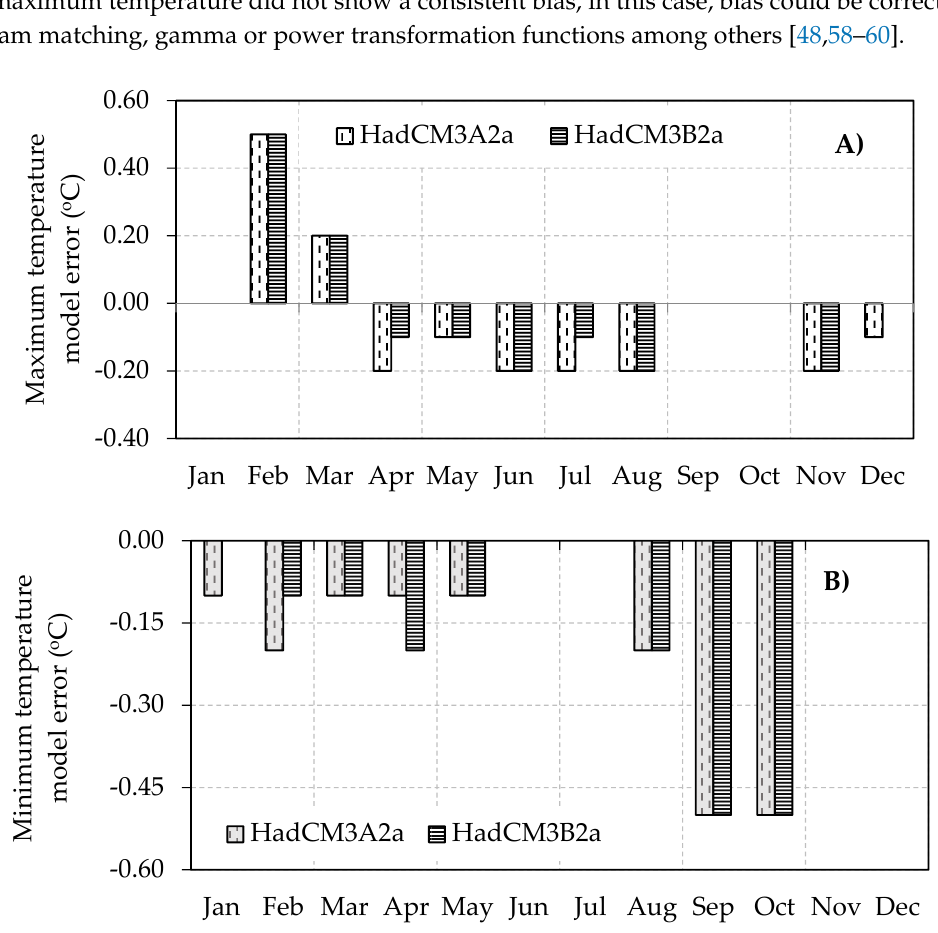
Figure 5. The HadCM3A2a and HadCM3B2a model error of minimum and maximum temperature for the baseline period (1961–1990): ( A ) monthly minimum temperature difference between downscaled and observed for baseline period; and ( B ) maximum temperature difference between downscaled and observed for the baseline period.